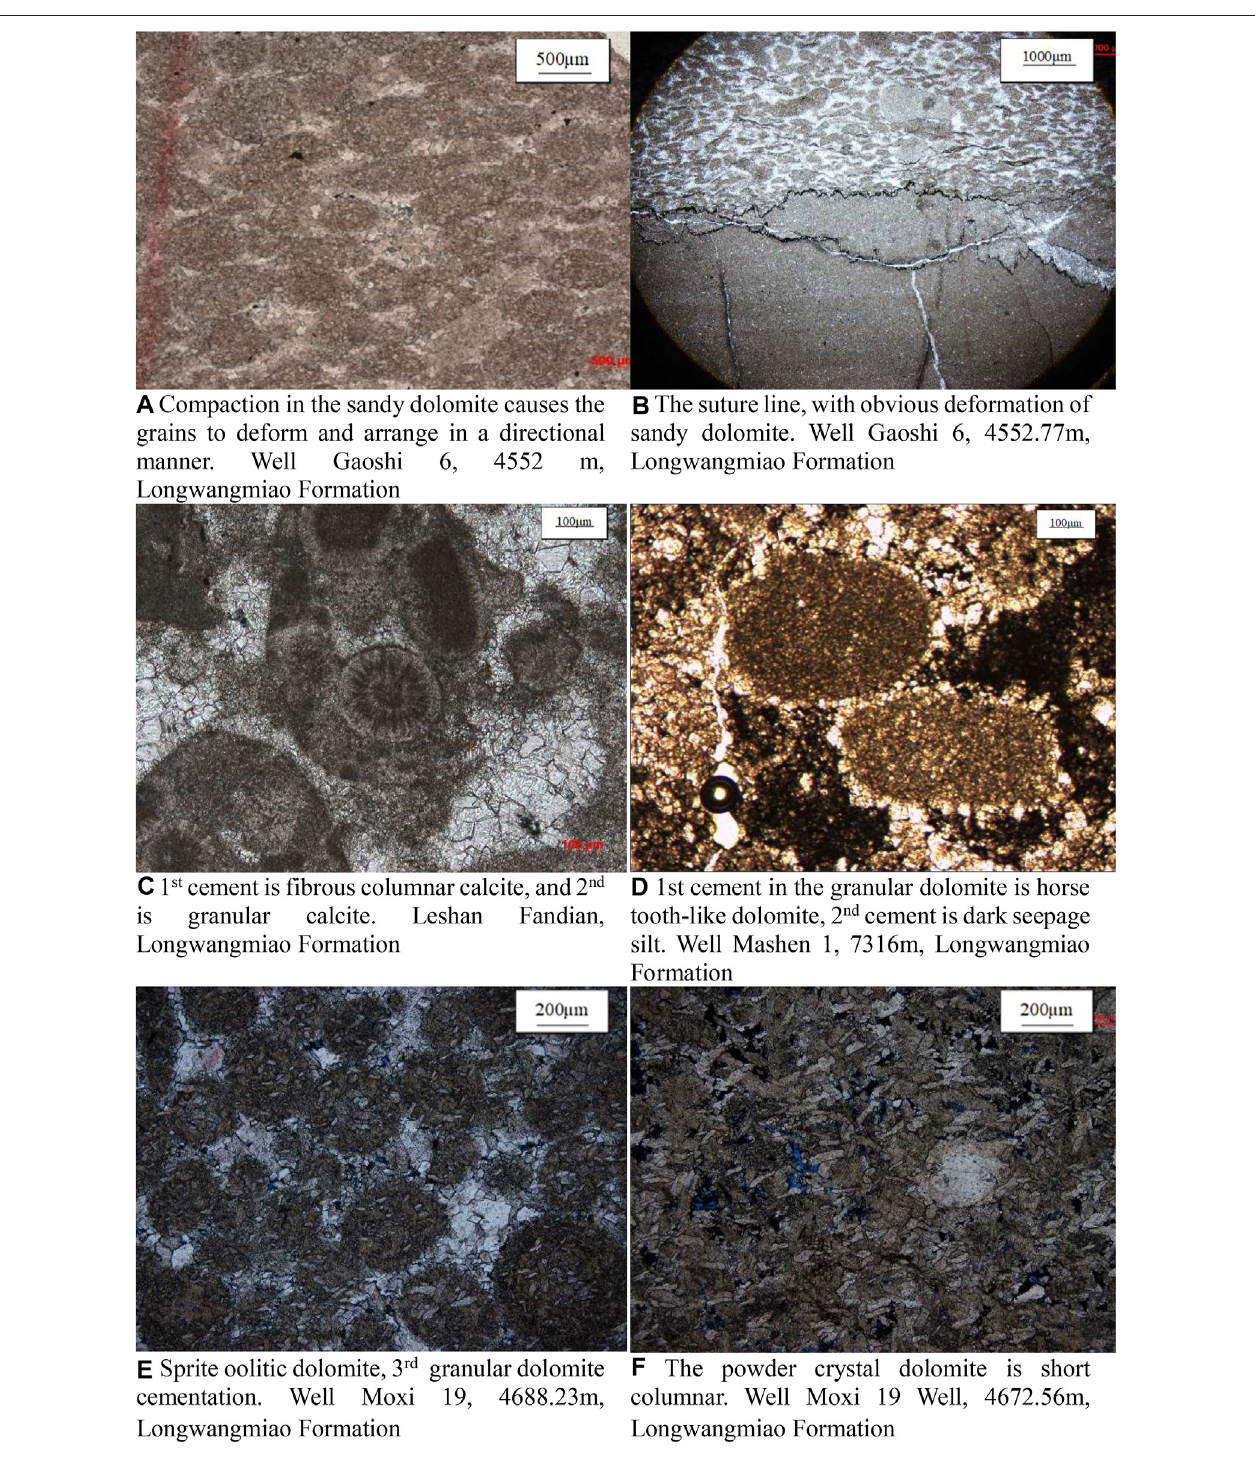
FIGURE 3 | Destructive diagenesis characteristics of the Longwangmiao Formation reservoir in the Sichuan Basin. (A) . Compaction in the sandy dolomite causes the grains to deform and arrange in a directional manner. Well Gaoshi 6, 4552 m, Longwangmiao Formation, (B) . the Suture line, with Obvious deformation of Sandy dolomite. Wellgaoshi 6,4,552.77 m, longwangmiao formation, (C) .1stcement is fi brouscolumnarcalcite, and 2ndis granularcalcite.Leshan Fandian, Longwangmiao Formation, (D) . 1st cement in the granular dolomite is horse tooth-like dolomite, 2nd cement is dark seepage silt. Well Mashen 1, 7,316 m, Longwangmiao Formation, (E) . Sprite oolitic dolomite, 3rd granular dolomite cementation. Well Moxi 19, 4,688.23 m, Longwangmiao Formation, (F) . The powder crystal dolomite is short columnar. Well Moxi 19 Well, 4,672.56 m, Longwangmiao Formation.